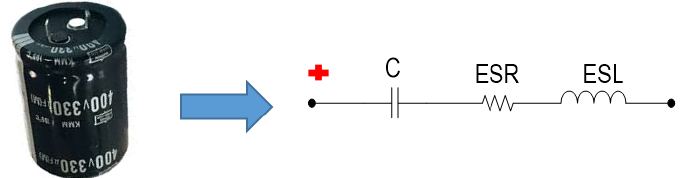
Figure 3. AEC’s simplified equivalent circuit.